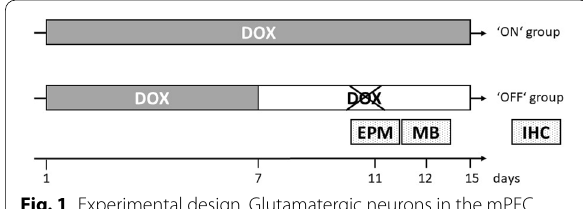
Fig. 1 Experimental design. Glutamatergic neurons in the mPFC of rats were transduced with D1R or dsRed. After recovery from virus injection rats were treated for 7 continuous days with DOX to induce virus over-expression. In one half of the subjects, virus over-expression was maintained and is referred to as ‘ON’. The ‘OFF’ group was not further provided with DOX after initial 7 days of virus over-expression. Behavioral experiments (EPM: Elevated Plus Maze and MB: Marble burying) were performed on day 11 and 12, respectively. Subjects were sacrificed via perfusion on day 15 and immunohistochemistry (IHC) was performed